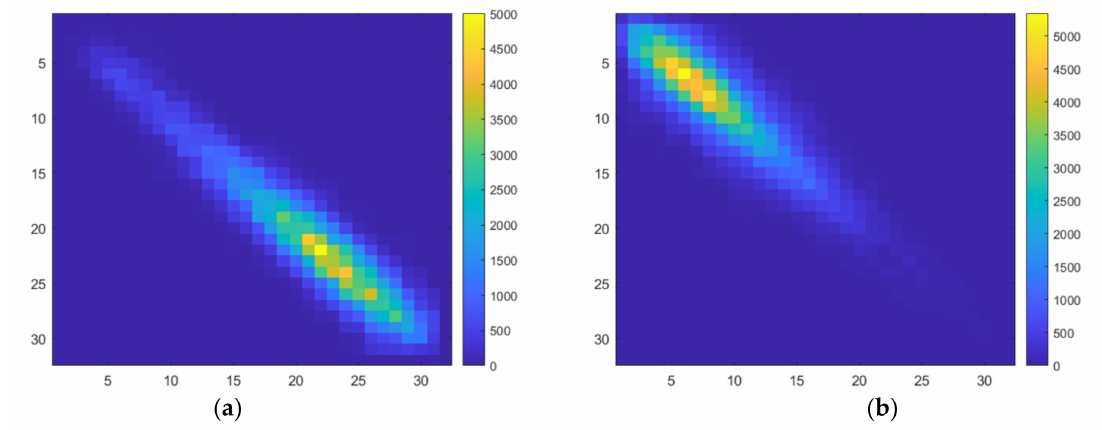
Figure 16. ( a ) GLCM matrix ( b ) GMCM matrix computed for an image obtained by